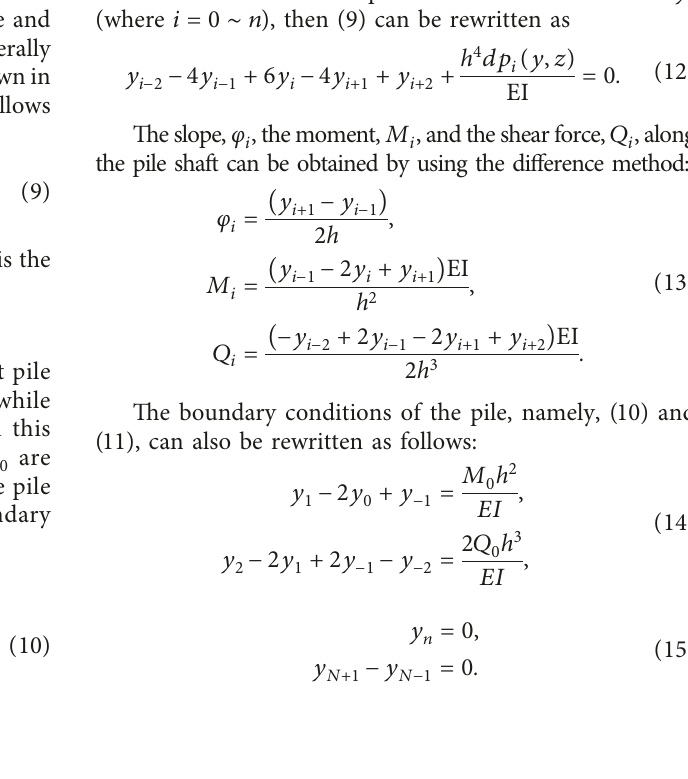
3.3. Finite Difference Solution. Subdividing the pile into N sections, the length of each section is h l / N , as shown in (cid:31) Figure 4. According to the principle of the central dif- ference method, two virtual nodes are added at the pile head and toe, respectively. Thus, there are N + 1 nodes on the pile shaft (node number: from 0 to N ), 2 virtual nodes at the top (node number: 2 and 1), and another 2 virtual nodes at the toe (node number: N + 1 and N + 2). − −